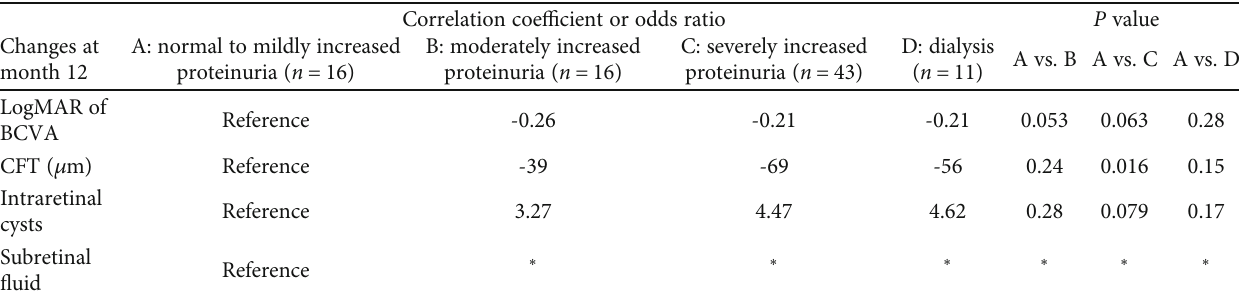
Table 3: Correlation between proteinuria status and changes in visual acuity and optical coherence tomography characteristics after month 12 after ranibizumab treatment.